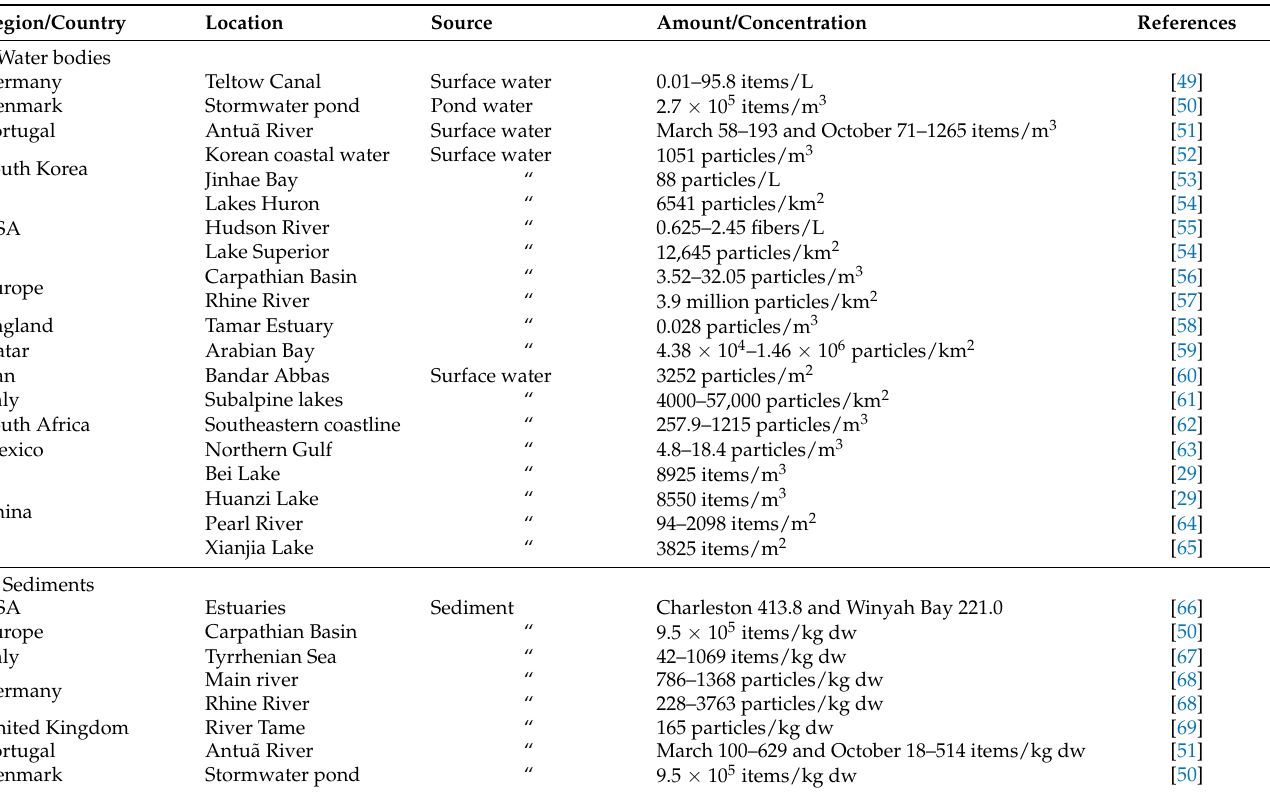
Table 1. Distribution and concentrations of microplastics in marine environments (water bodies and sediments) as well as wastewater effluents in different regions of the